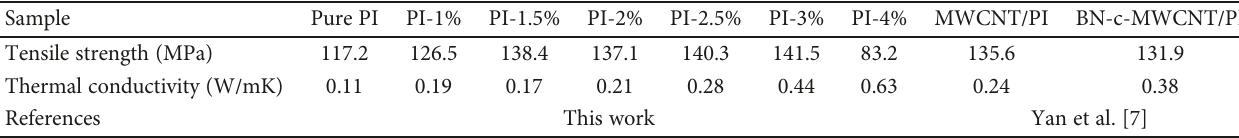
Table 2: Mechanical properties and thermal conductivity of pure PI and MWCNTs-ODA/PI composite fi lms. Sample Pure